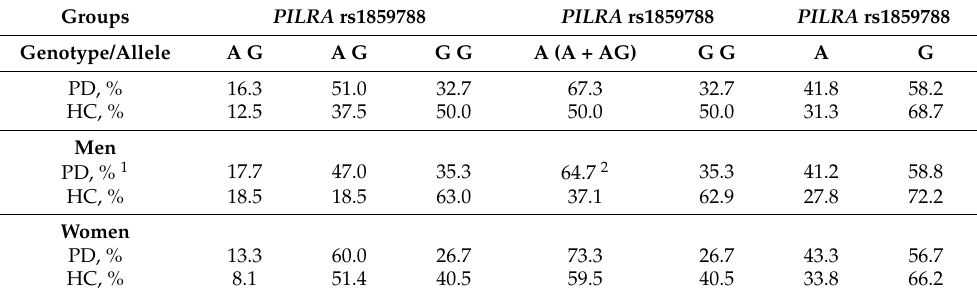
Table 3. Genotype and allelic distribution of PILRA rs1859788 polymorphism in the individuals enrolled in the study.